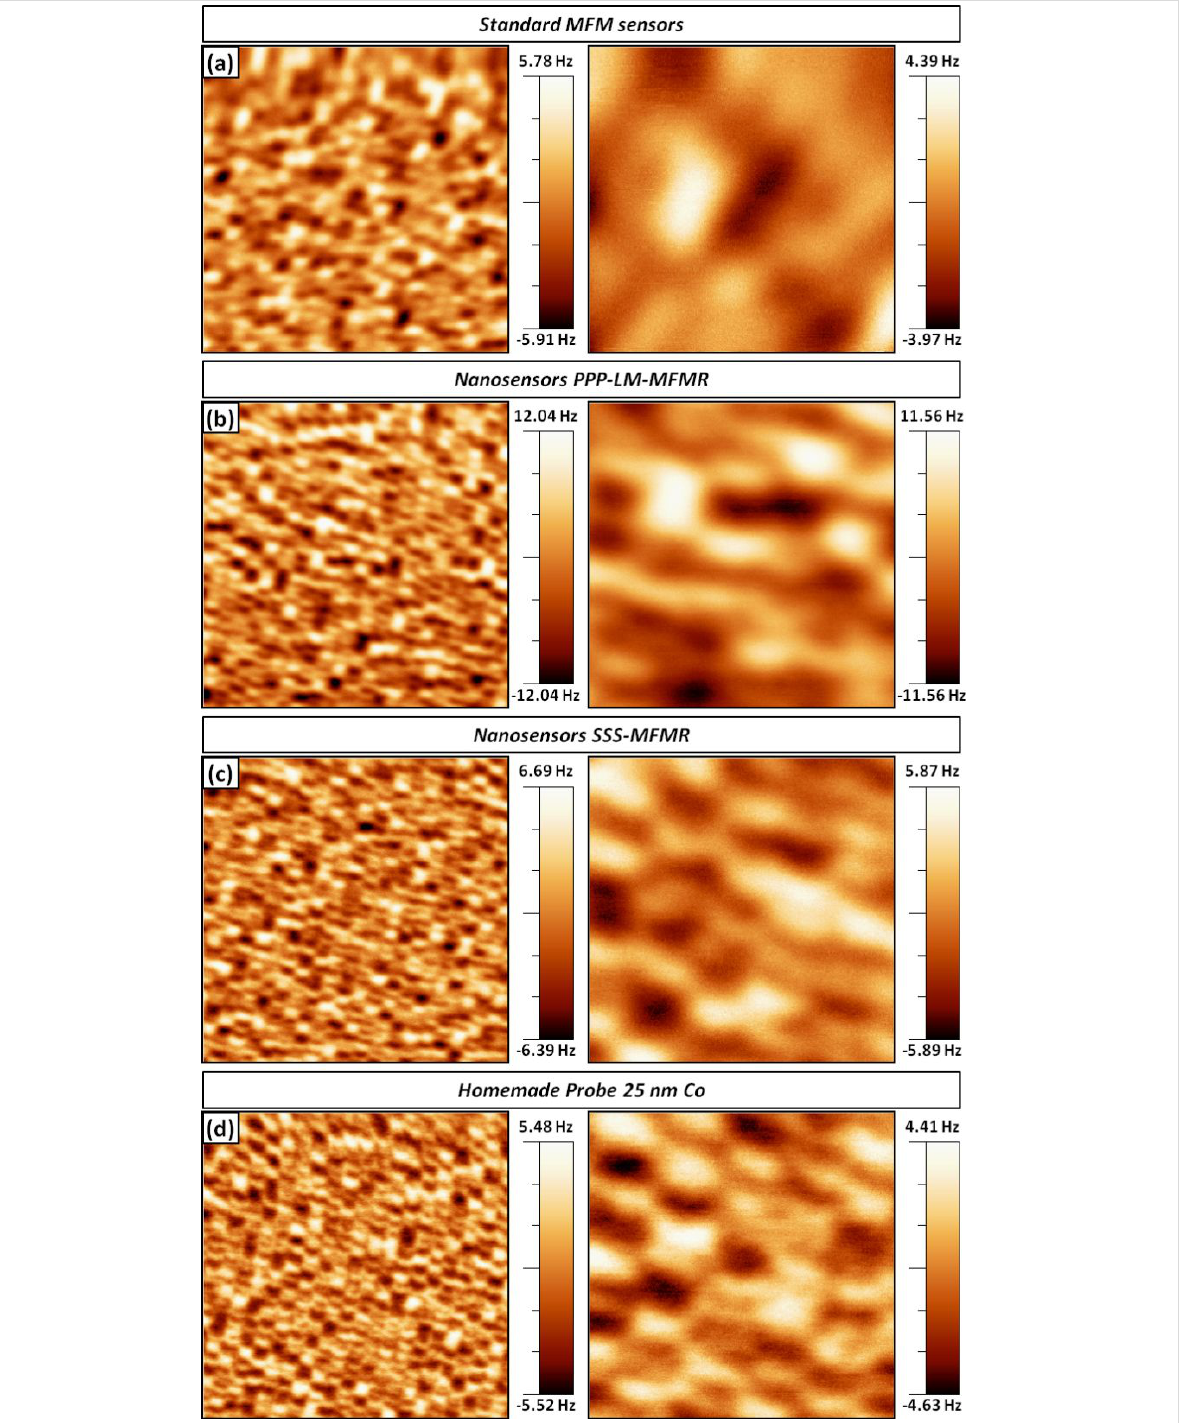
Figure 2: MFM images performed to show the lateral resolution obtained with commercial (a) standard, (b) low-moment and (c) super sharp probes and (d) custom-made tips with a 25 nm thick Co coating on the front sides. Images on the left/right columns are (2 × 2) μ m 2 /(500 × 500) nm 2 , respec-